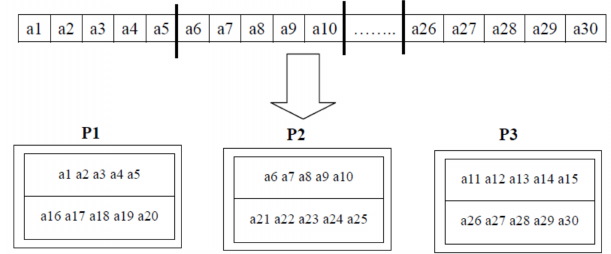
Figure 14. Example of block cyclic distribution.